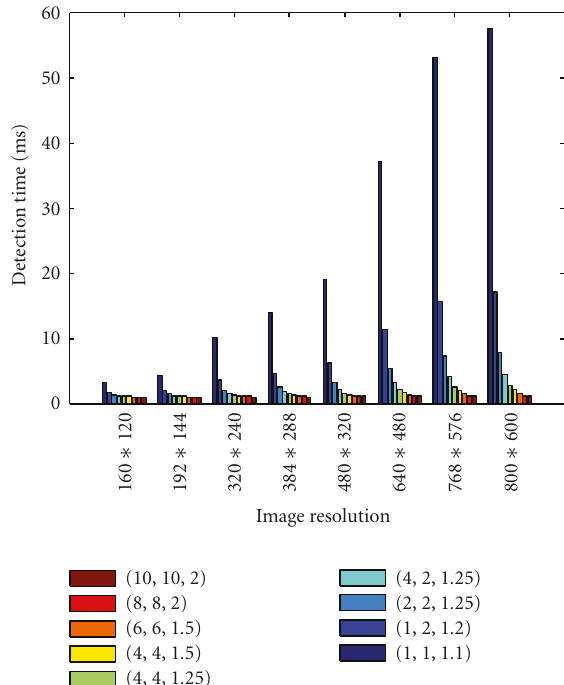
Figure 17: Variation of detection speed while changing S x , S y and r